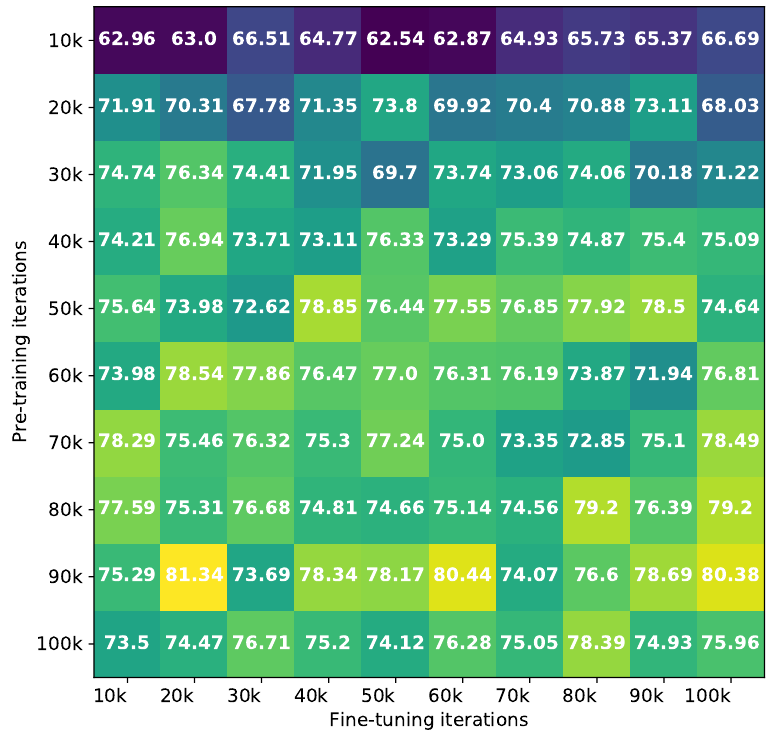
Figure 8. The classification accuracies of the networks trained on 5 samples/class and tested with the rest of the image using the Indian Pines dataset and neural network based on [16]. On the y-axis, the number of epochs for the pre-training stage is written, while on the x-axis the number of epochs for the fine-tuning stage is written. The resuts suggest higher relative importance of the pre-training stage in comparison to the fine-tuning